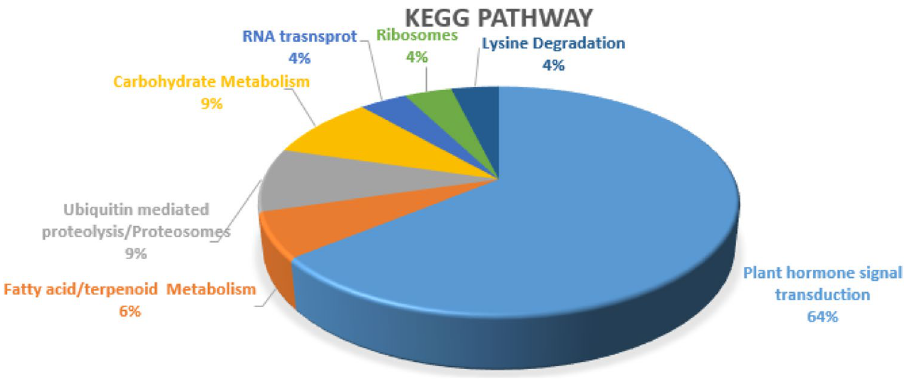
Figure 2. KEGG pathway analysis of parthenocarpy-PPI Network. Majority of the proteins in the parthenocarpy-PPI network are involved in plant hormone signal transduction (64%) followed by carbohydrate and ubiquitin mediated proteolysis (9%). Details of genes involved in the respective KEGG pathway are given in Supplementary Table